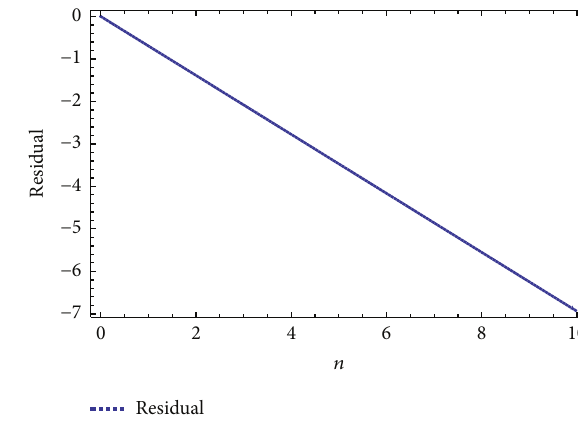
Figure 5: Residual of (42) at 𝑡 = 1